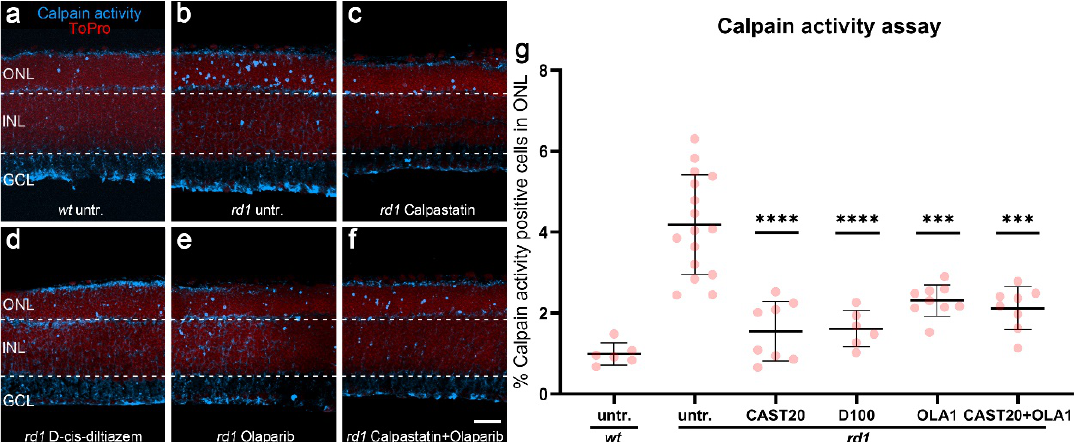
Figure 1. Effects of calpastatin, D-cis-diltiazem, Olaparib, and combination treatments on calpain activity. The calpain activity assay (blue) was performed on unfixed wt ( a ) and rd1 retinal cross- sections. ToPro (red) was used as nuclear counterstaining. Untreated rd1 retina (untr.; b ) was compared to retina treated with either calpastatin ( c ), D-cis-diltiazem ( d ), Olaparib ( e ), or calpastatin and Olaparib combined ( f ). The scatter plots show the percentages of outer nuclear layer (ONL) cells positive for calpain activity ( g ) in wt and rd1 retina. Statistical significance was assessed using one-way ANOVA and Tukey’s multiple comparison post hoc testing performed between the control ( rd1 untreated) and 20- µ M calpastatin (CAST20), 100- µ M D-cis-diltiazem (D100), 1- µ M Olaparib (OLA1), and 20- µ M calpastatin combined with 1- µ M Olaparib (CAST20+OLA1). All treatments reduced the calpain activity in rd1 ONL; however, there was no added synergistic benefit from the CAST20+OLA1 combination. Untr. wt : 6 explants from 3 different mice; untr. rd1 : 16/16; CAST20 rd1 : 8/8; D100 rd1 : 6/6; OLA1 rd1 : 9/9; CAST20+OLA1 rd1 : 8/8; error bars represent SD; *** = p ≤ 0.001 and **** = p ≤ 0.0001. INL = inner nuclear layer, GCL = ganglion cell layer. Scale bar = 50 µ